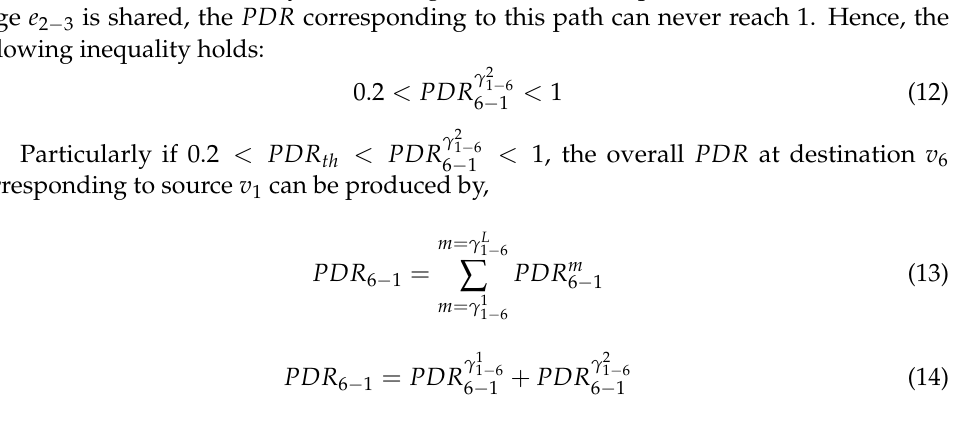
The corresponding resiliency curve is shown in Figure 6. As